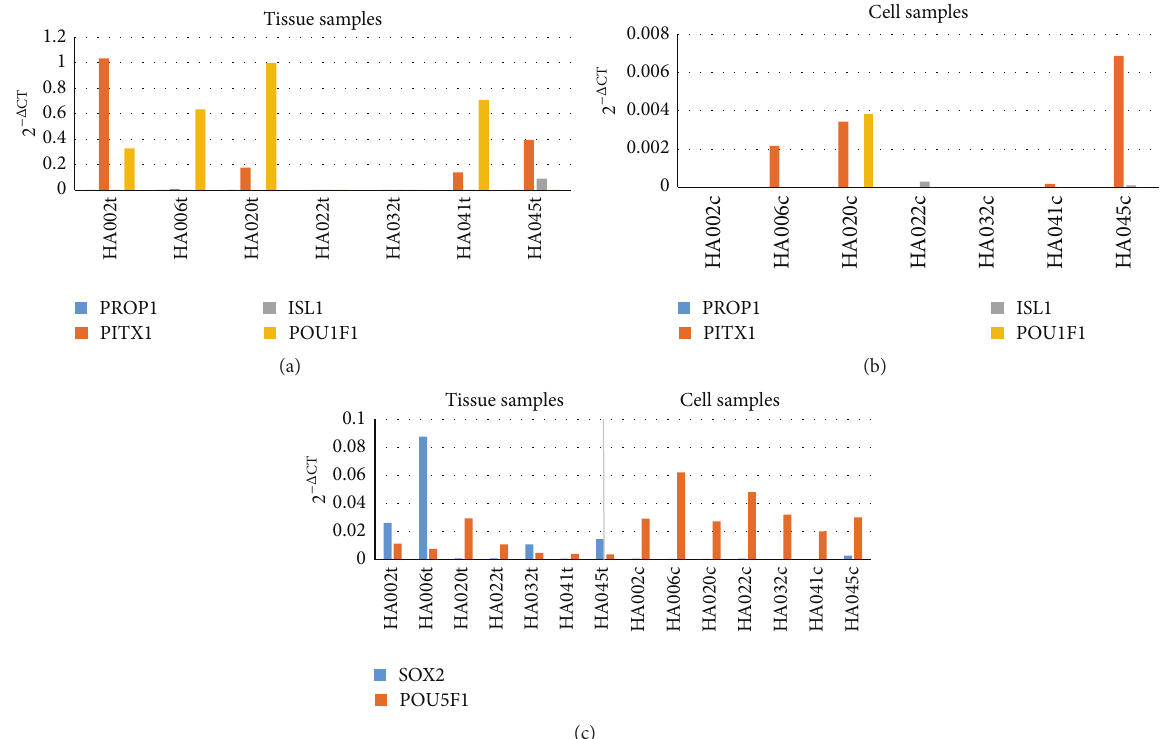
Figure 3: Expression of pituitary parenchymal progenitor cell markers in adenoma tissues and corresponding cell cultures. Values are calculated using comparative ( 2 −Δ Ct ) method and mean Ct values from experiments performed in triplicate. Although adenoma tissue samples showed meaningful expression of markers from pituitary parenchymal cells and progenitors (a), their expression in cell cultures was substantially lower (b). PROP1, PROP paired-like homeobox; PITX1, paired-like homeodomain 1; ISL1, ISL LIM homeobox 1; POU1F1, POU class 1 homeobox 1; SOX2, SRY-box 2; POU5F1, POU class 5 homeobox